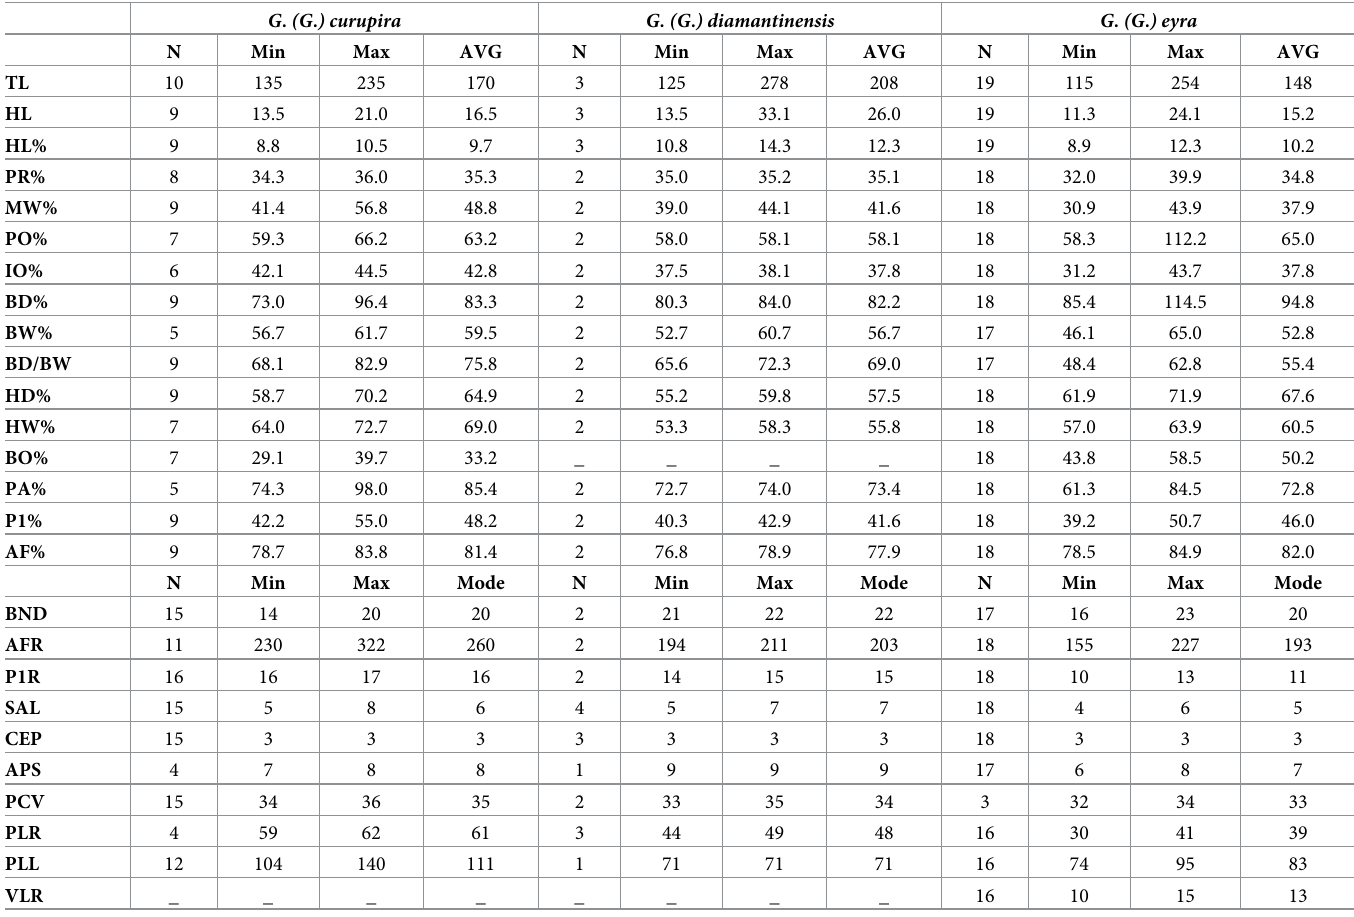
Table 9. Summary of morphometric and meristic data for Gymnotus (G . ) curupira , G . (G . ) diamantinensis and G . (G . ) eyra . G . (G . )